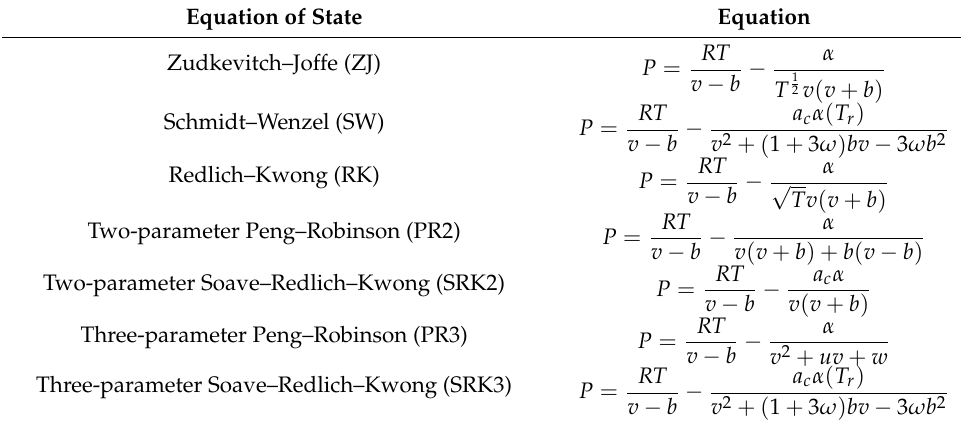
Table 5. Formulas of the used EOSs [13].